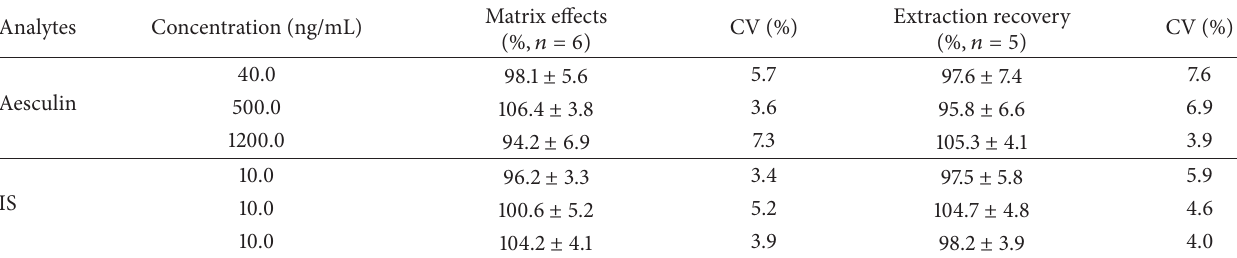
Table 1: Matrix effects and extraction recovery of aesculin and the internal standard in rat plasma.